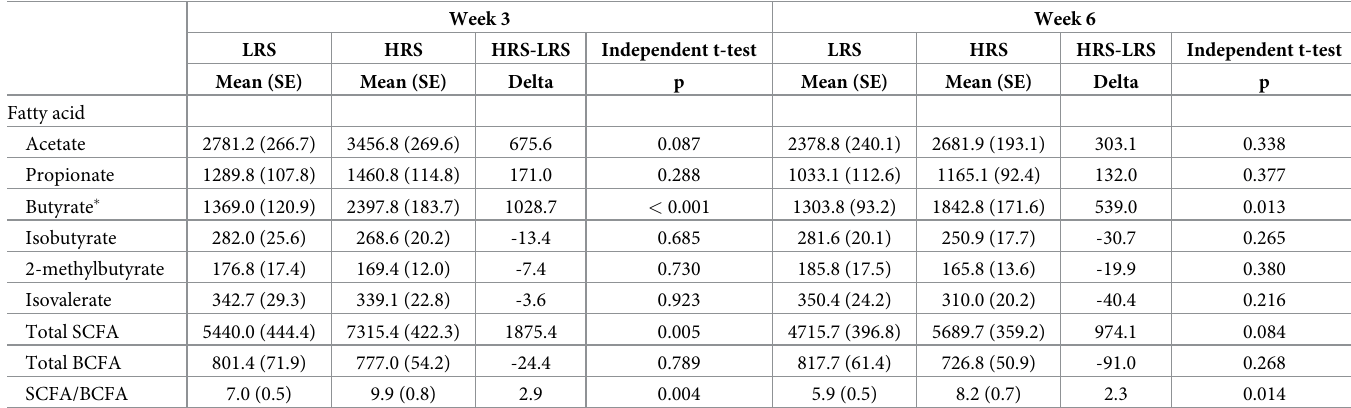
Table 4. Short-chain fatty acids in fecal samples taken at weeks 3 and 6 from cats fed LRS or HRS